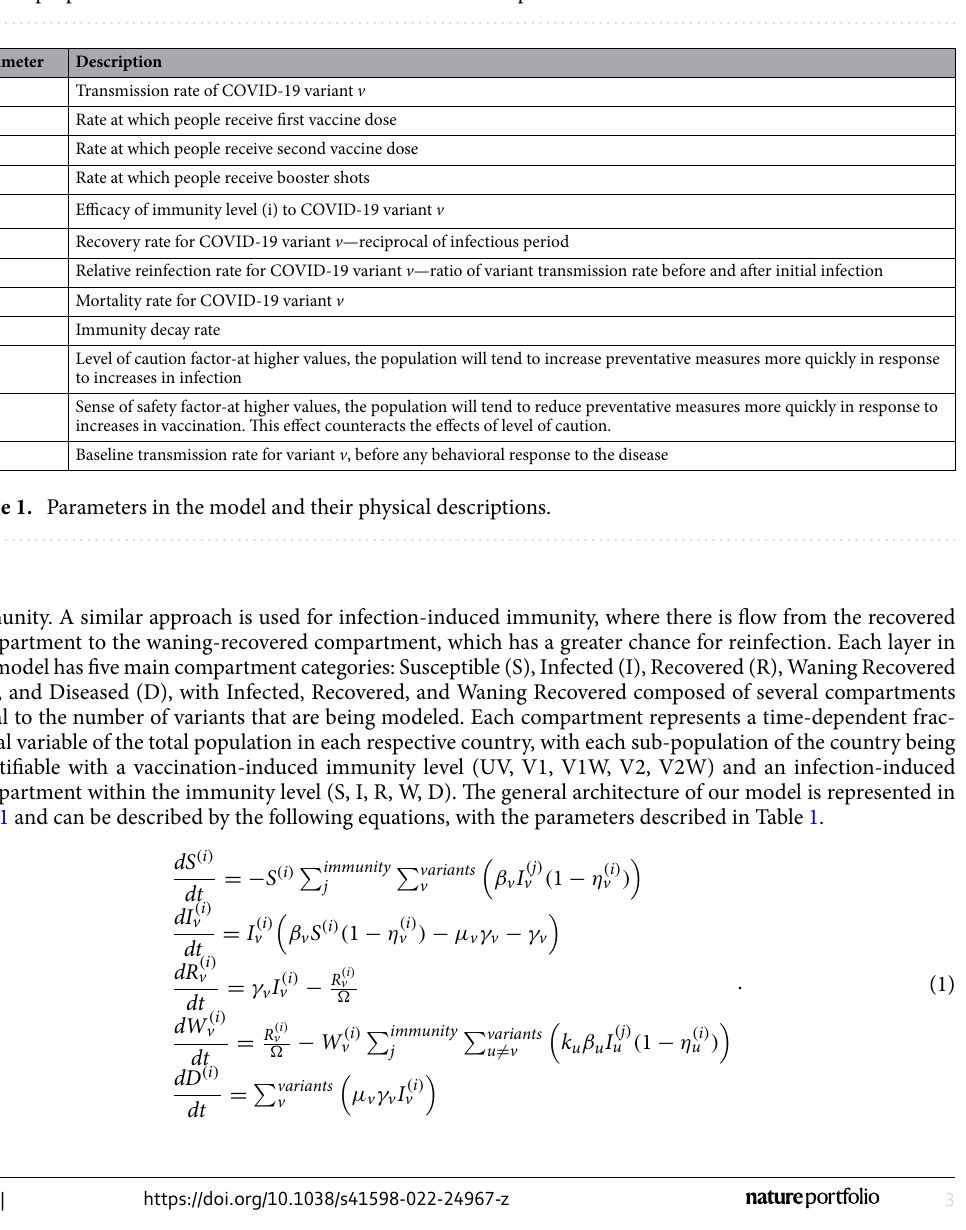
Figure 1. Schematic representation of proposed stacked compartment model. We propose a model that splits the population into a series of vaccination-related immunity levels and uses sub-compartments within each level to represent variants and infection-related disease states. The 2D figure (left) represents the compartment model within an immunity level, composed of a single susceptible (S) and deceased (D) compartment, as well as an infected (I), recovered (R), and waning recovered (W) compartment for each prevalent variant. The 3D figure (right) shows the entire model, where stacked immunity levels represent waning vaccination status. The dotted boxes contain several sub-compartments. Arrows representing flow from the dotted boxes in the 2D figure indicate proportional flow from each of the contained sub-compartments.